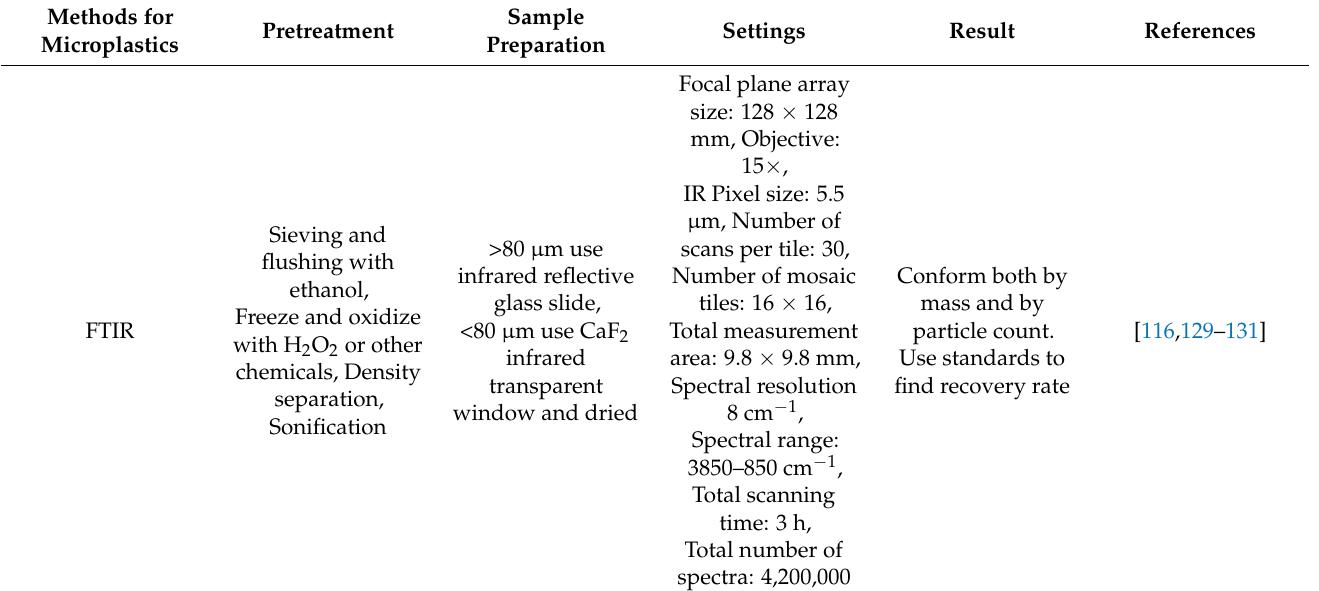
Table 5. FTIR setting condition for microplastic